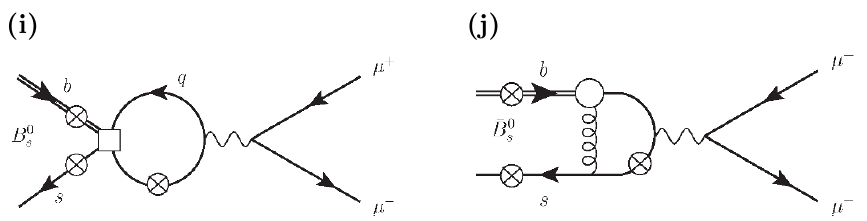
! (cid:22) + (cid:22) (cid:0) (cid:13) process to lowest order. s